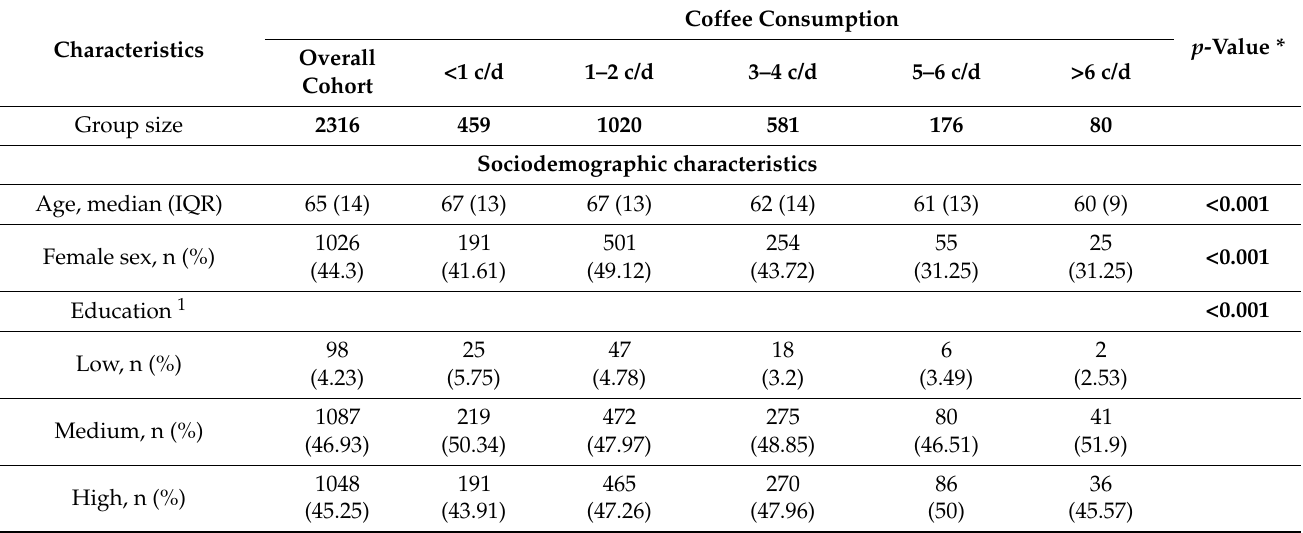
Table 1. Descriptive statistics of the overall cohort, as well as for each group of coffee